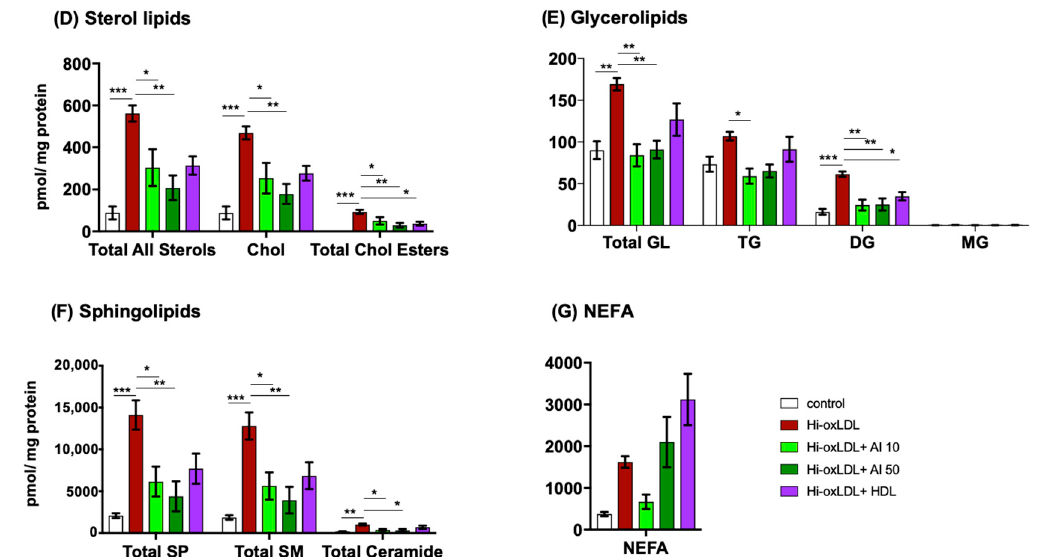
Figure 5. Untargeted global lipidomics. ( A ) Total lipids detected in each treatment group. ( B ) Heat map showing the relative abundance of five lipid categories as % of each category to total detected lipids. ( C ) Phospholipids. Total amount of phospholipids detected in each treatment group (top) and each class of phospholipids regulated by cholesterol acceptors (bottom). ( D – G ) The levels of sterol lipids, glycerolipids, sphingolipids, and non-esterified fatty acids (NEFA) in each group. The amount of lipid detected was presented as pmol lipid normalized to mg protein. TG; triglyceride, DG; diglyceride, MA; monoglyceride. The data were presented as mean ± SEM ( n = 4 per group). * p < 0.05, ** p < 0.005, *** p < 0.0005, **** p < 0.00005. Hi-oxLDL versus hi-oxLDL + A-I 50: ## p < 0.005, #### p < 0.00005 . Hi-oxLDL versus hi-oxLDL+ HDL: ☨☨ p < 0.005, ☨☨☨☨ p < 0.0005.